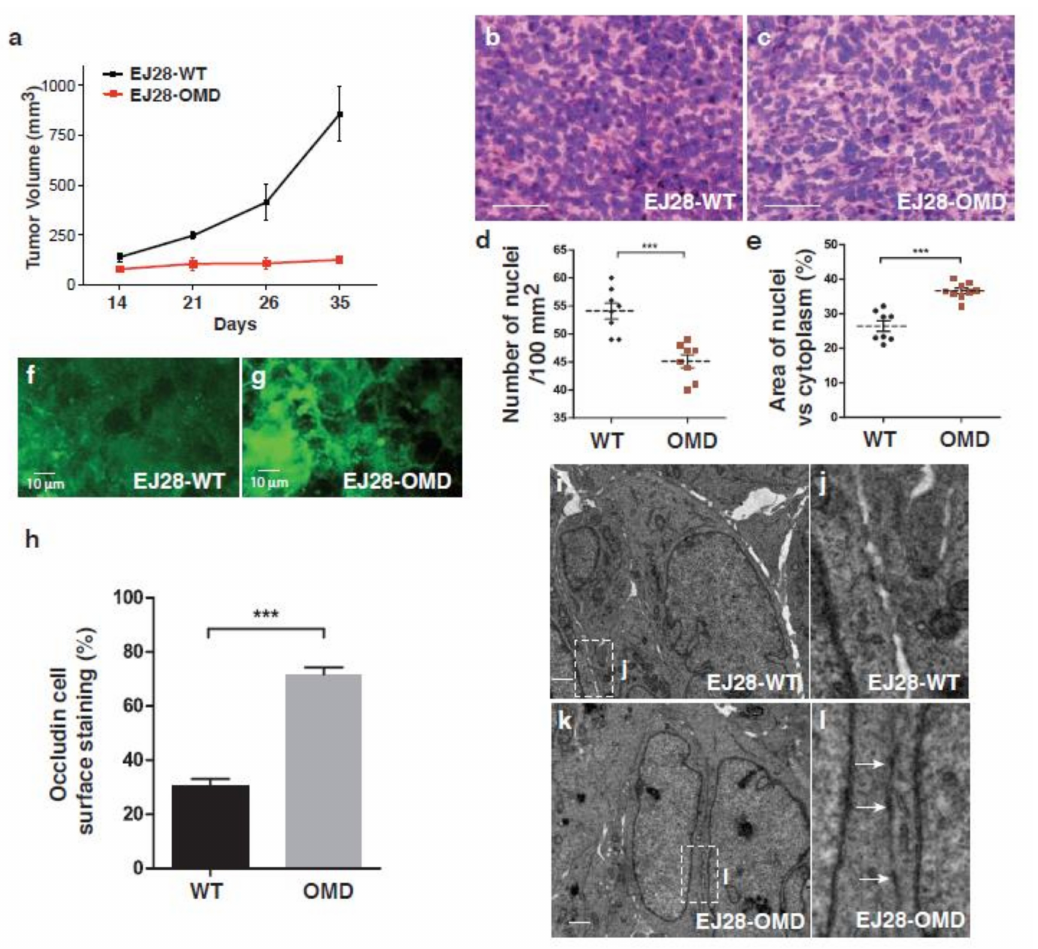
Figure 6. Mouse xenograft model overexpression of OMD. ( a ) Xenograft of EJ28 cells stably expressing OMD. Tumor volume progression graph. EJ28- WT ( n = 5) and EJ28-OMD ( n = 5). ( b – e ) Histology of xenografted tissues; H&E staining of control EJ28 cells ( b ) and EJ28 cells overexpressing OMD ( c ), comparison of the number of nuclei in 100 µ m 2 of sections ( d ), comparison of the ratio of nucleus vs cytosol. ( e ) Scale bar represents 100 µ m ( b , c ). ( f , g ) Occludin staining of control EJ28 tumor ( f ) and OMD overexpressing EJ28 tumor ( g ). ( h ) Quantification of occludin staining. The stained percentage of cell surfaces was measured. ( i ) EM of control EJ28 cells. ( j ) Enlarged from ( i ). (k) EM of OMD-overexpressing EJ28 tumor cells. Scale bar represents 1 µ m ( i,k ). (l) Enlarged from ( k ). Tight junctions are shown with arrows. *** indicates p <